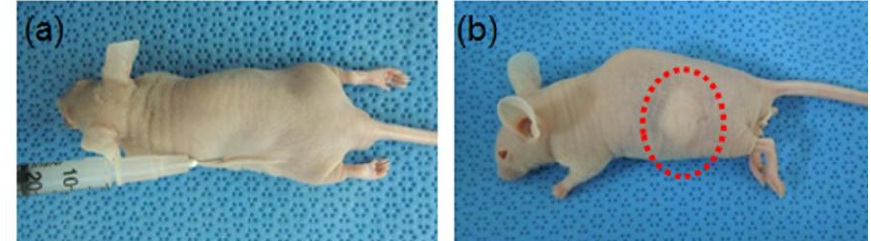
Figure 4. Image obtained ( a ) after the initial injection of the hEBs/F embedded in the in situ -forming MCL hydrogel; and ( b ) 12 weeks after hydrogel